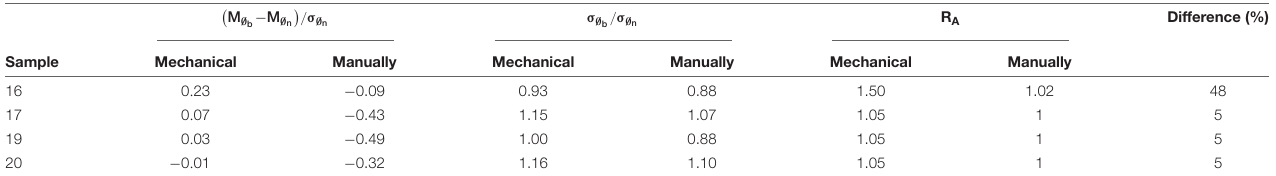
The difference in percentage of the R A with mechanical and manual procedures is also